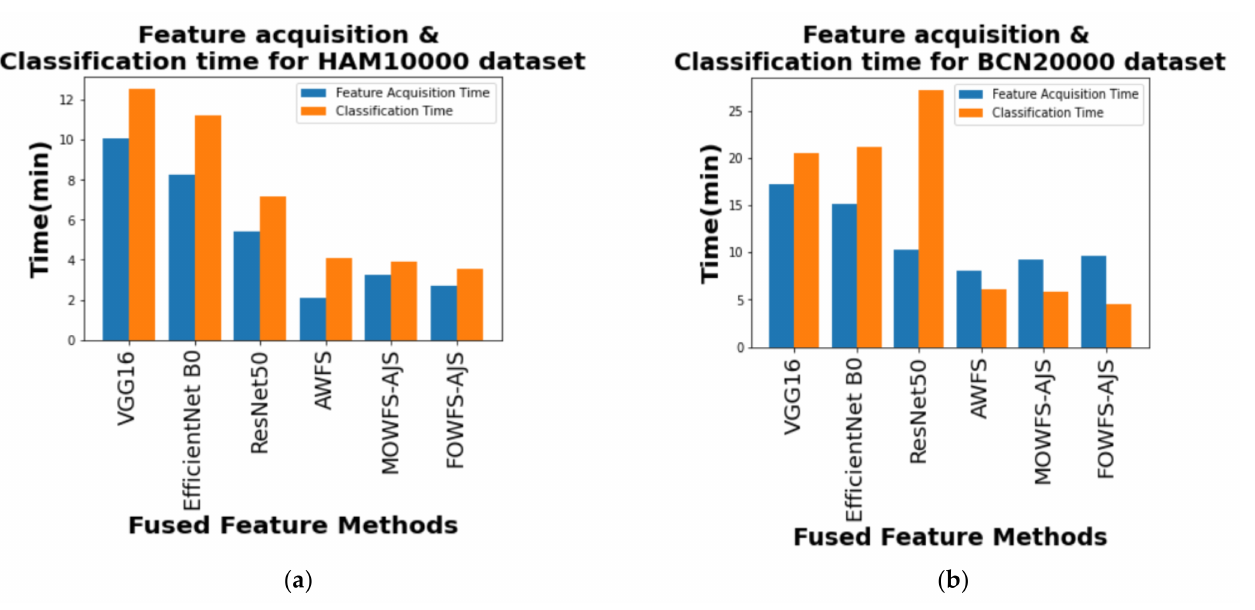
Figure 14. Comparison of mean feature acquisition time vs. classification time of DT, NB, MLP, and SVM classifiers for ( a ) HAM 10000 dataset and ( b ) BCN 20000